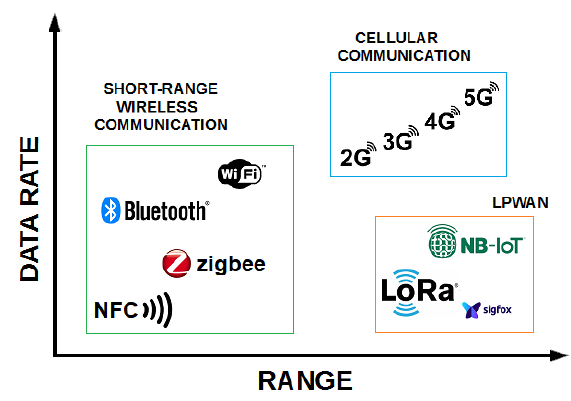
Figure 1. Data rate vs. a range of several IoT communication protocols.